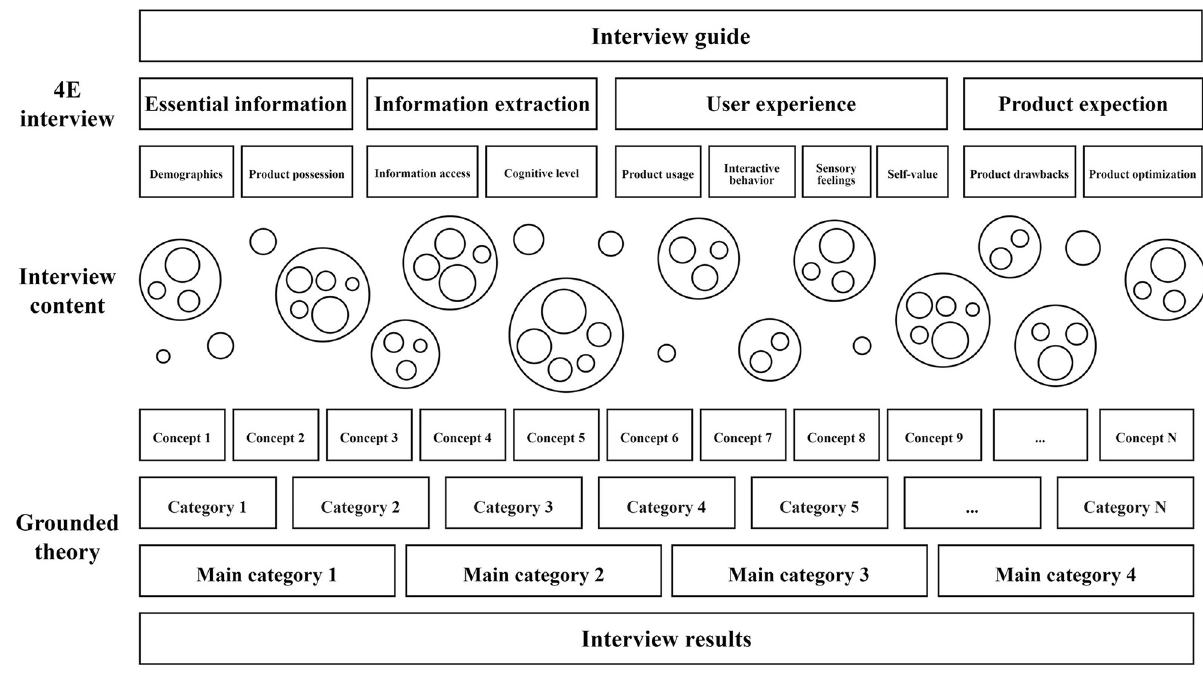
Fig 1. Illustration of 4E interview-grounded theory